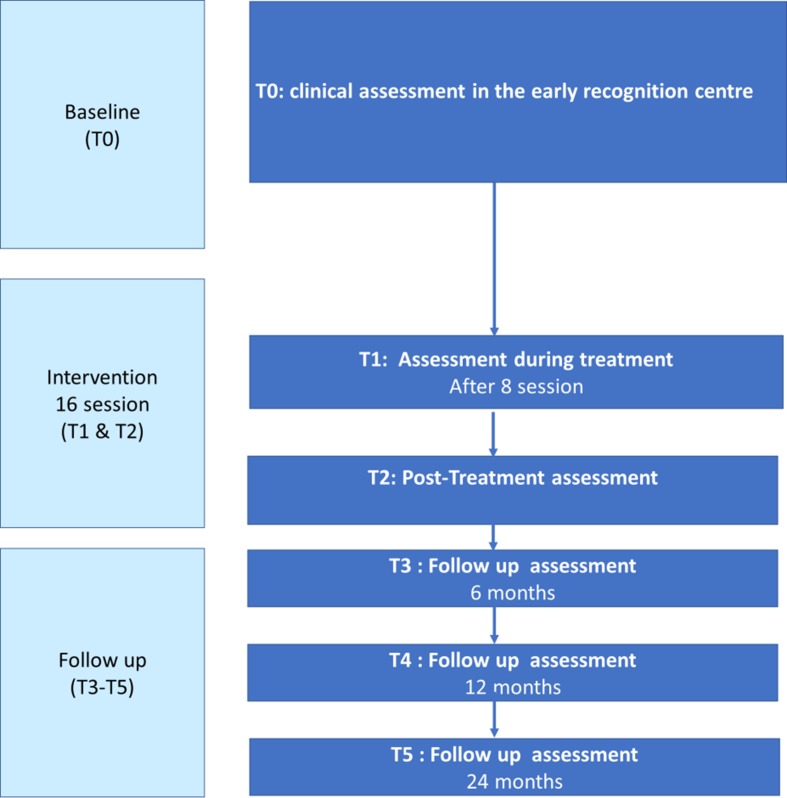
Flow chart of the assessments from baseline to 24 months of follow-up.